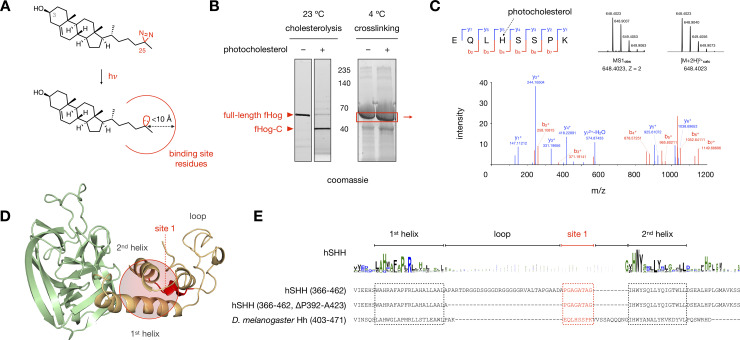
Photocholesterol labels an essential region of the SRR loop.(A) Activation of the C25 diazirine in photocholesterol with 368 nm UV light yields a reactive carbene with a crosslinking radius of <10 Å (ref 51). (B) Left: Stain-Free gel showing cholesterolysis of an aliquot of fHog protein. (1 mM DTT, ± 50 μM photocholesterol, 23°C, 4 h). Right: Representative Coomassie-stained gel showing fHog protein incubated with photocholesterol or vehicle (1 mM DTT, ± 50 μM photocholesterol, 0°C, 4 h) and exposed to 368 nM light (5 min, 0°C). Protein in the red box was excised, digested with trypsin, and analyzed by mass spectrometry. (C) Mass spectrum of a crosslinked peptide at site 1; the photocholesterol-modified histidine residue is indicated by a dashed black arrow. For full assignments, see S1 File. (D) A sphere encompassing residues within 10 Å of the loop identified by site 1 (red) in the hSHH apo Hog model. (E) Alignment of the helix-loop-helix motifs in fHog and hSHH shows putative homology between the fHog crosslinking site 1 and the 8 residues of the hSHH SRR loop that are required for cellular cholesterolysis. fHog cholesterolysis with photocholesterol and crosslinking/mass spectrometry were performed in biological triplicate.